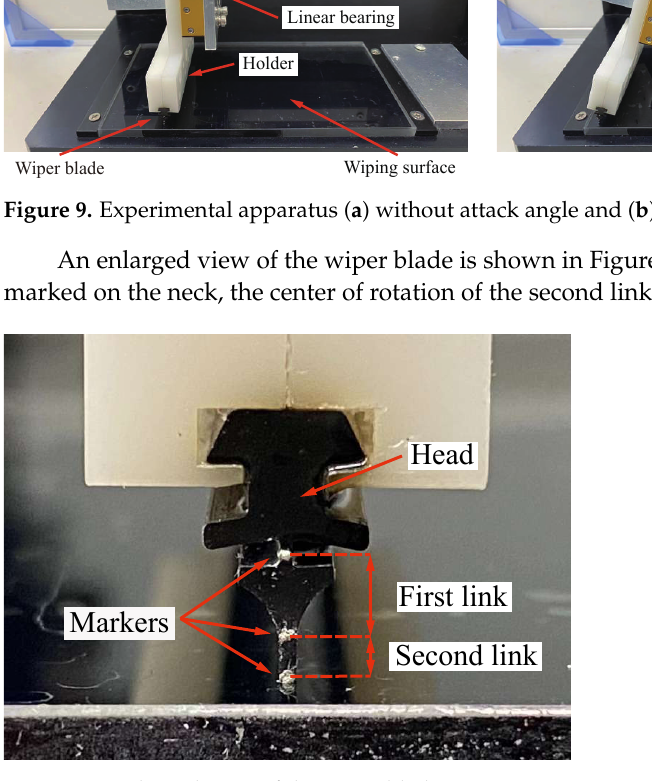
Figure 10. Enlarged view of the wiper